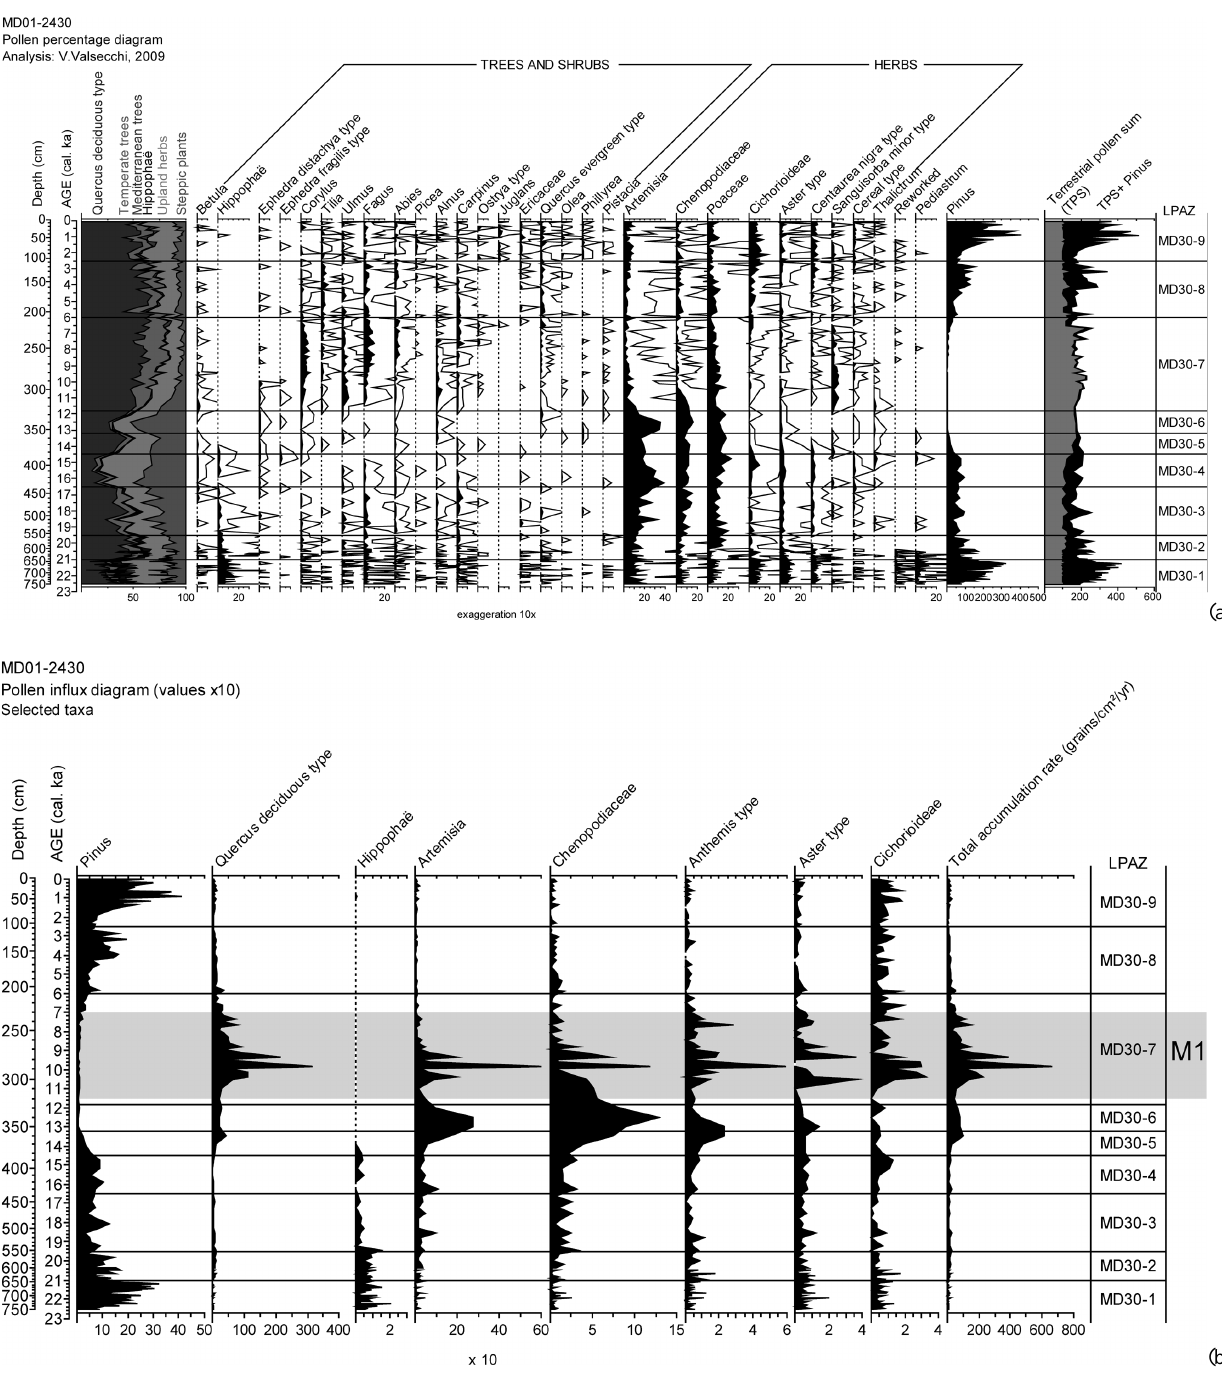
Fig. 3. (a) Pollen percentage diagram for core MD01-2430 showing only selected taxa. Pinus , aquatics, ferns and reworked pollen are not included in the pollen sum. Mediterranean trees include Quercus evergreen type, Cistus , Olea , Phillyrea and Pistacia . Steppic plants include Artemisia , Chenopodiaceae, Ephedra distachya type and E. fragilis type. Filled black curves show the percentage values of single pollen type; white curves indicate percentages enlarged by ten. (b) Pollen influx diagram for core MD01-2430 showing only selected taxa. Gray band indicates the Sapropel 1